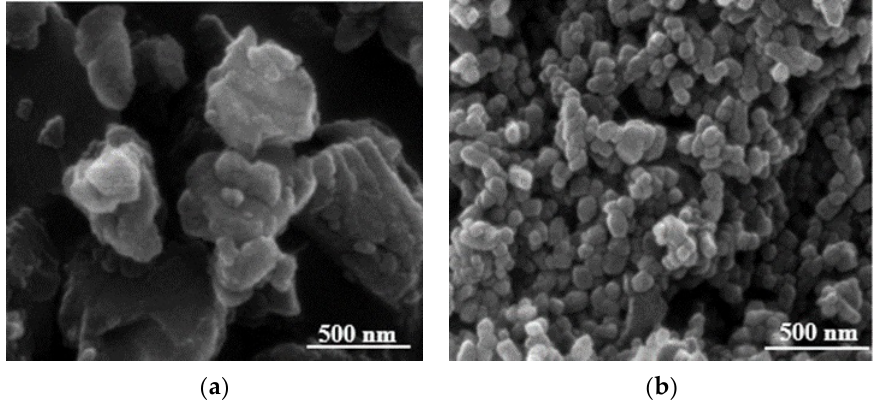
Figure 1. The SEM images of ( a ) micro-CaCO 3 (MCC) and ( b ) nano-CaCO 3 (NCC) in spherical shape.